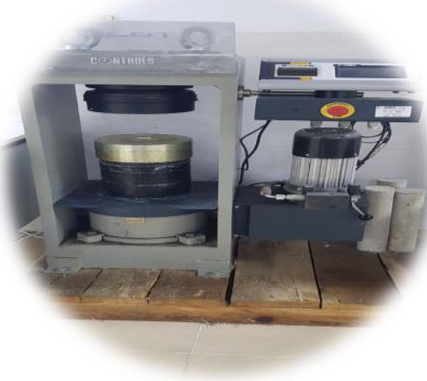
Figure 3. Compression machine.